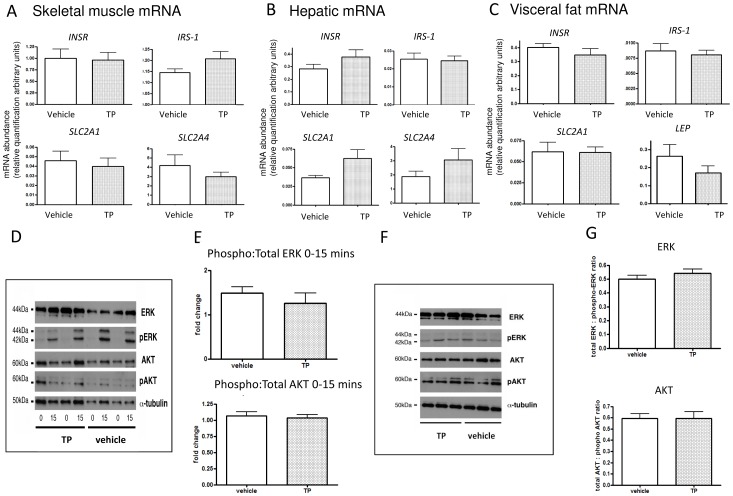
Molecular determination of skeletal muscle and hepatic insulin signalling in d62MI-TP 11 month old female offspring.Gene expression (Panels A–C, vehicle treated n = 5; TP treated n = 9) and protein phosphorylation (Panels D and F vehicle treated n = 5; TP treated n = 5) and its quantification (Panels E and G) relevant to insulin signalling in muscle, liver and visceral fat was analyzed in early adult female offspring from MI-TP pregnancies. No significant alterations in expression of key insulin signalling and reception genes were evident in either tissue associated with prenatal treatment. Panel D shows representative western blots of insulin signalling proteins (MAPK and AKT pathways) in muscle biopsies before and after glucose bolus and Panel F shows these pathways in muscle at sacrifice two weeks later after glucose bolus from the aforementioned pregnancies. Quantified data from these western blots in shown in Panels E and G – there were no differences in ratios of total : phosphorylated ERK or AKT associated with prenatal treatment.